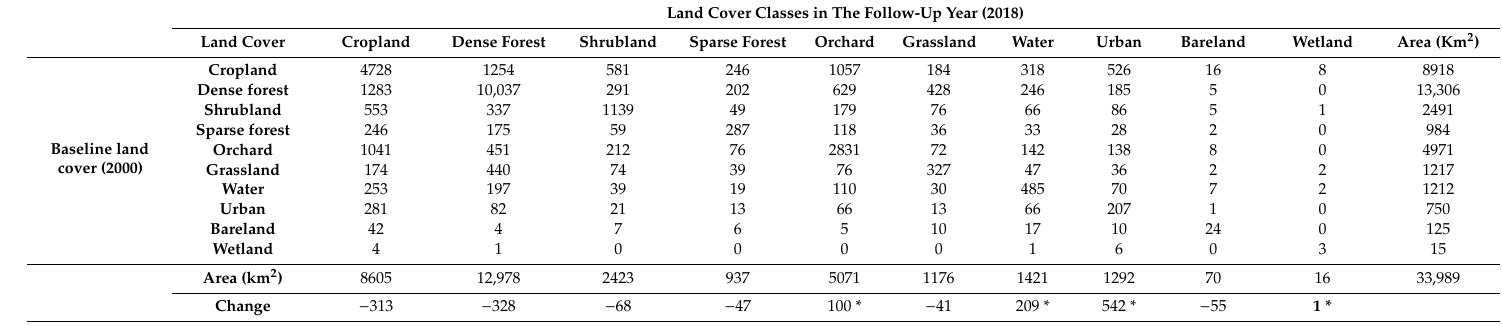
Table 3. The land cover changes between 2000 and 2018 (* represents land cover classes that increased in size in 2018 in comparison to their baseline areas in